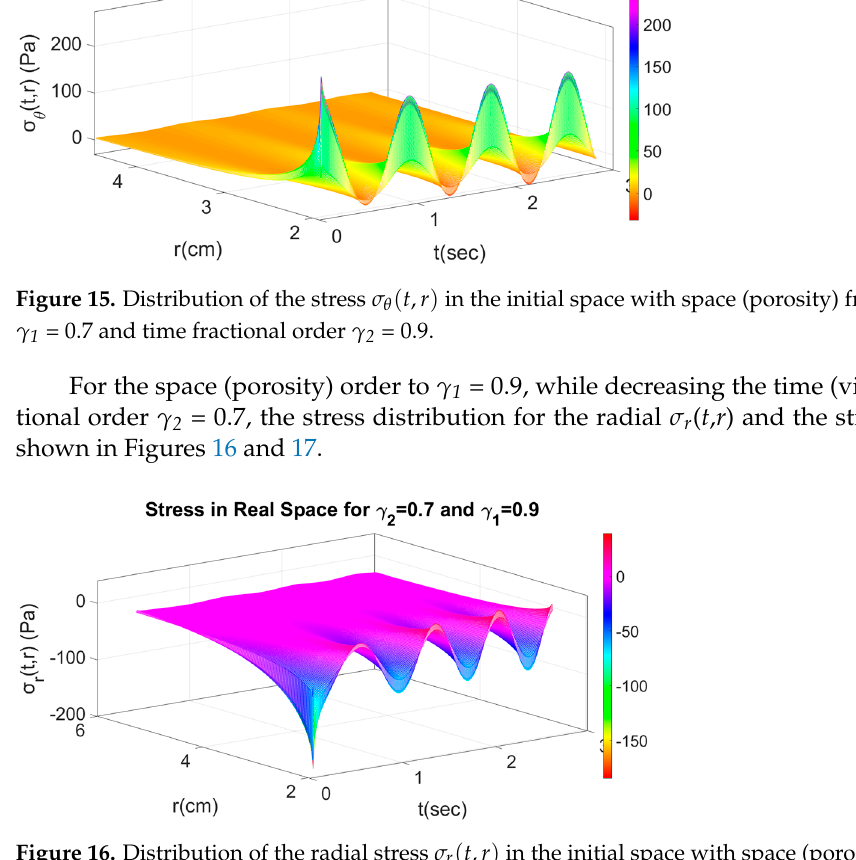
Figure 17. Distribution of the stress 𝜎 (cid:3087) (𝑡,𝑟) in the initial space with space (porosity) fractional order γ 1 = 0.9 and time fractional order γ 2 = 0.7. Figures 12–19 show the influence of the fractional orders, time and space, upon the stresses. The less the fractional time–fractional order or the space (porosity) fractional or- der, the higher the stresses. Figure 18. Distribution of the radial stress 𝜎 (cid:3045) (𝑡, 𝑟) in the initial space with space (porosity) fractional order γ 1 = 0.7 and time fractional order γ 2 = 0.7.